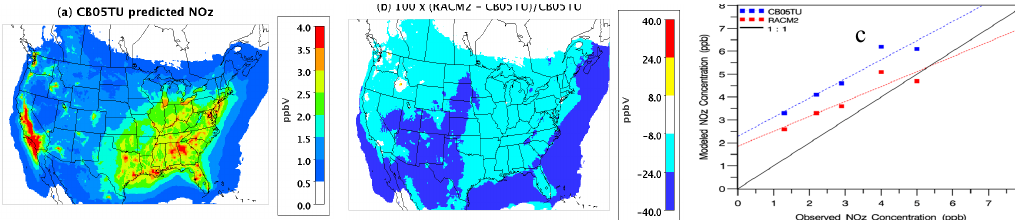
Figure 5: (a) Predicted mean surface O 3 obtained with CB05TU (b) percent differences in mean O 3 between RACM2 and CB05TU (c) Fig. 4. (a) Predicted mean NO z obtained with CB05TU, (b) percent differences in mean NO z between RACM2 and CB05TU, (c) a compar- a comparison of predicted mean 8-hr O 3 to observations from the Air Quality System. ison of predicted NO z to measurements from the Yorkville site of the South Eastern Aerosol Research and Characterization.